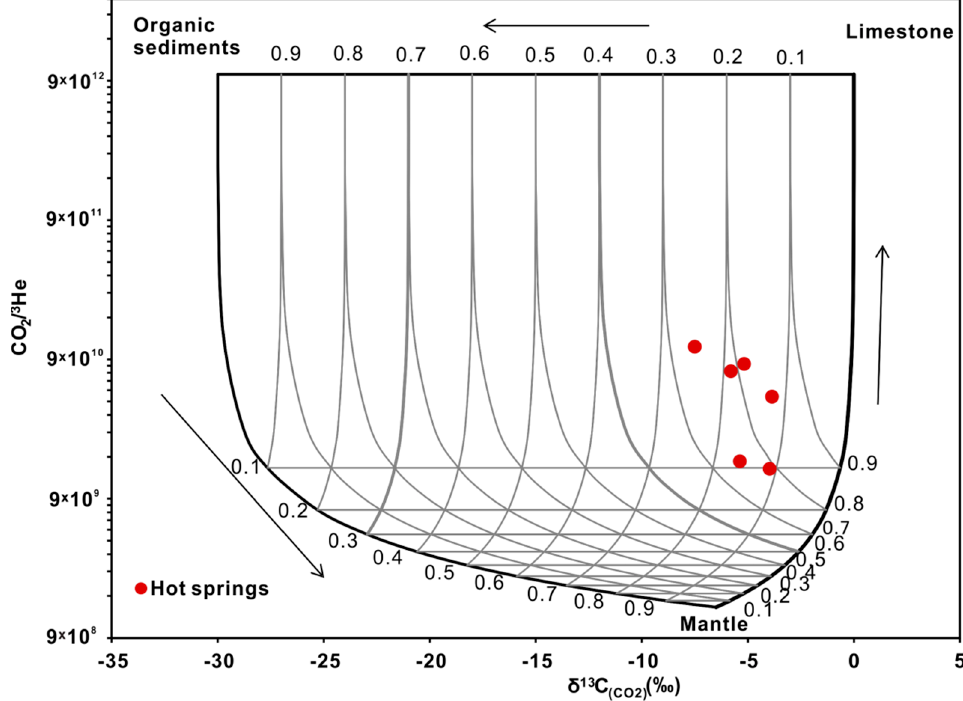
Figure 11. Variation in the CO 2 / 3 He ratio and δ 13 C CO2 composition of the geothermal gas. The compositional end members of organic sediments, limestone, and mantle have the following values: δ 13 C CO2 = − 30‰, 0‰, and − 6.5‰, CO 2 / 3 He = 1 × 10 13 , 2 × 10 9 and 1 × 10 13 , respectively